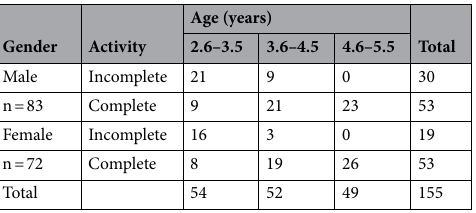
Table 1. Study participants details based on gender, age and activity